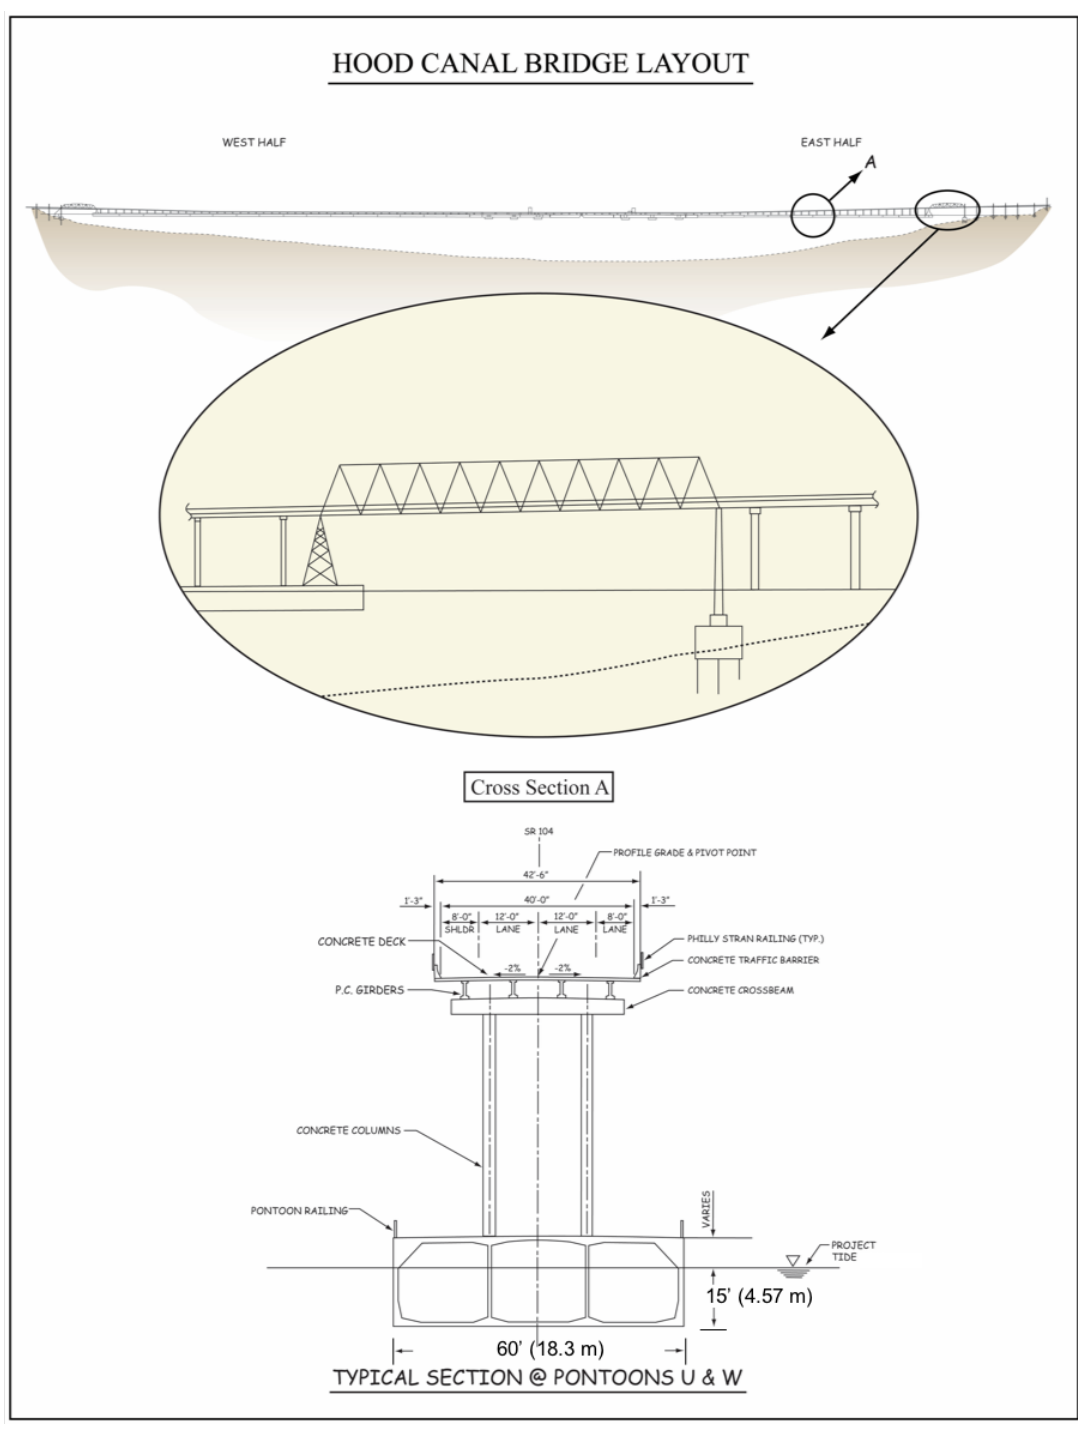
Figure 4. HCB layout with pontoon cross-section and east span details. Detail A is a sectional view across the width of the bridge.